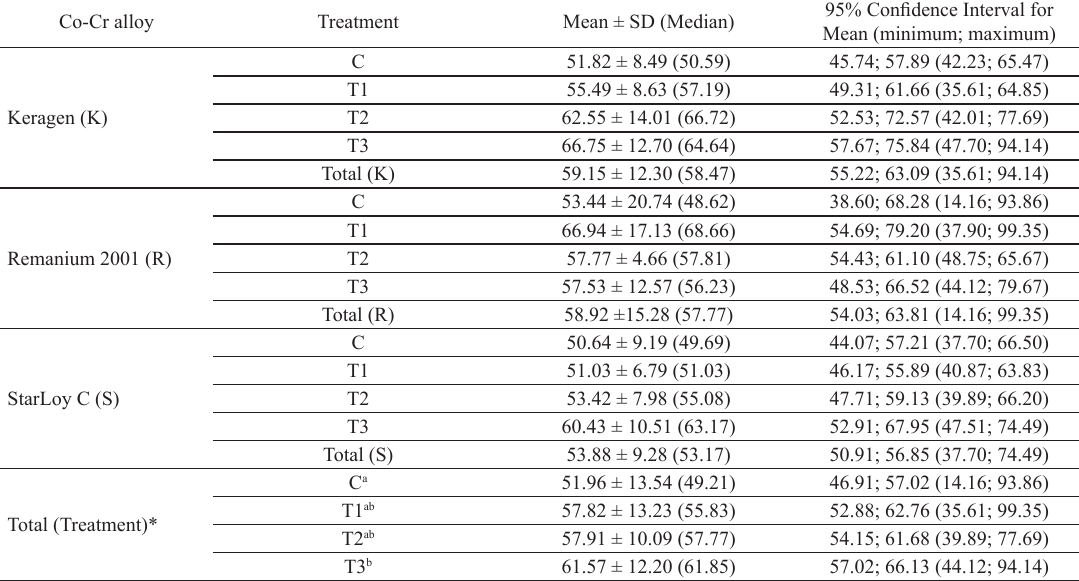
Table 3. Descriptive statistics of metal-ceramic bond strength (MPa) calculated for the variation factors: alloy, surface treatment and the interaction between alloy and surface treatment. Co-Cr